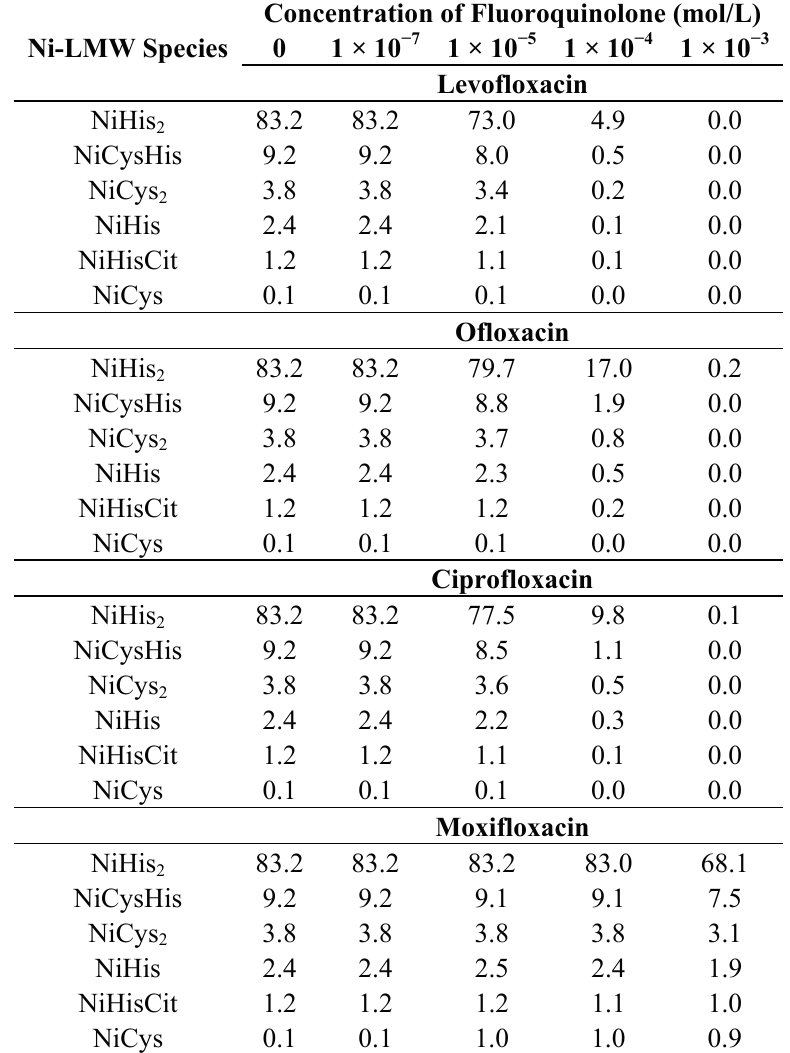
Table 10. Calculated bio-distribution of dominant Ni (II) species (%) in human blood plasma in the presence of